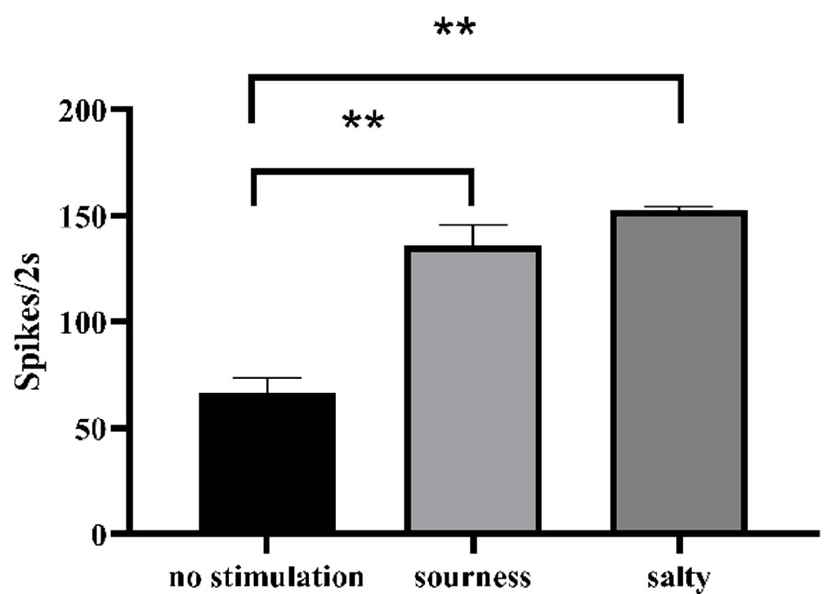
Figure 5. Spike responses of taste bud organoids are stimulated by different taste substances. All data represent the mean ± standard error of the mean (S.E.M.) and are shown in a histogram. ** p < 0.01 is considered as significant difference, Student’s t-test.